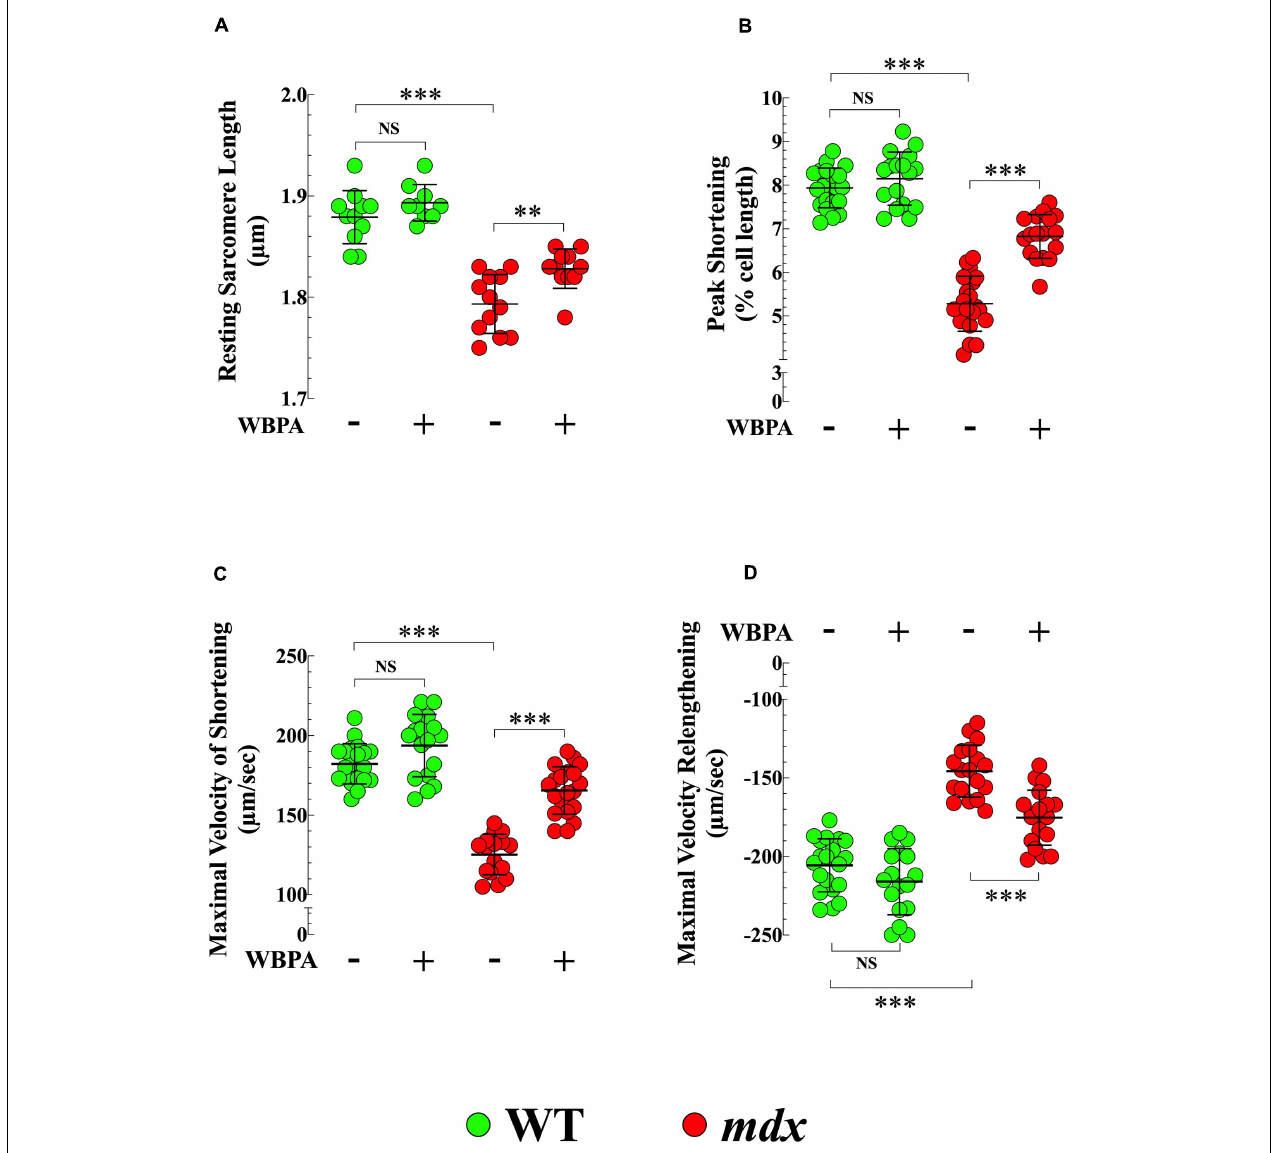
FIGURE 5 | Whole periodic body acceleration improved reduced contractility of mdx cardiomyocytes. Contractility was studied in cardiomyocytes from 15-month treated and untreated, WT and mdx . The resting sarcomere length was smaller in dystrophin-deficient mdx cardiomyocytes compared to WT (A) . Mdx cardiomyocytes showed a decrease of peak shortening (PS) (B) , of maximal velocity of shortening (+dL/dt) (C) , and of maximal velocity of relenthening (–dL/dt) (D) compared with age-match WT. The WBPA treatment returned the diastolic sarcomere length of mdx near WT cardiomyocytes values (A) and partially reversed the contractile dysfunction by significantly increasing PS (B) , +dL/dt (C) , and –dL/dt (D) . WBPA treatment did not significantly modify the contractile properties in WT cardiomyocytes, (C) . Untreated and WBPA-treated WT, N = 4 mice per experimental conditions , n = 21–17, respectively; Untreated and WBPA-treated mdx, N = 6 mice, per experimental conditions n = 17–20, respectively. Values are expressed as means ± S.D. One-way ANOVA with Tukey’s post-test, ** p ≤ 0.01, *** p ≤